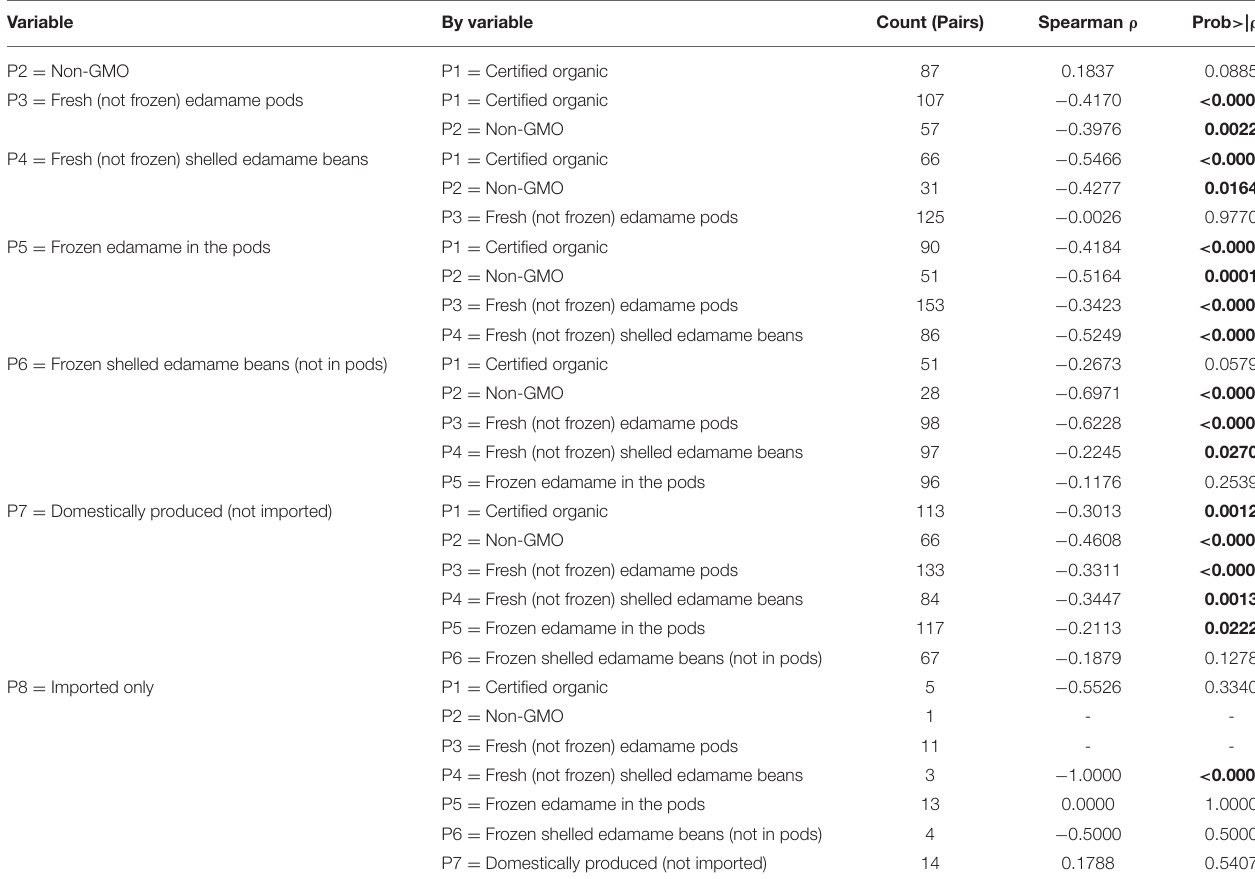
TABLE 7 | Correlation between edamame products ranked by consumers in the U.S. Variable By